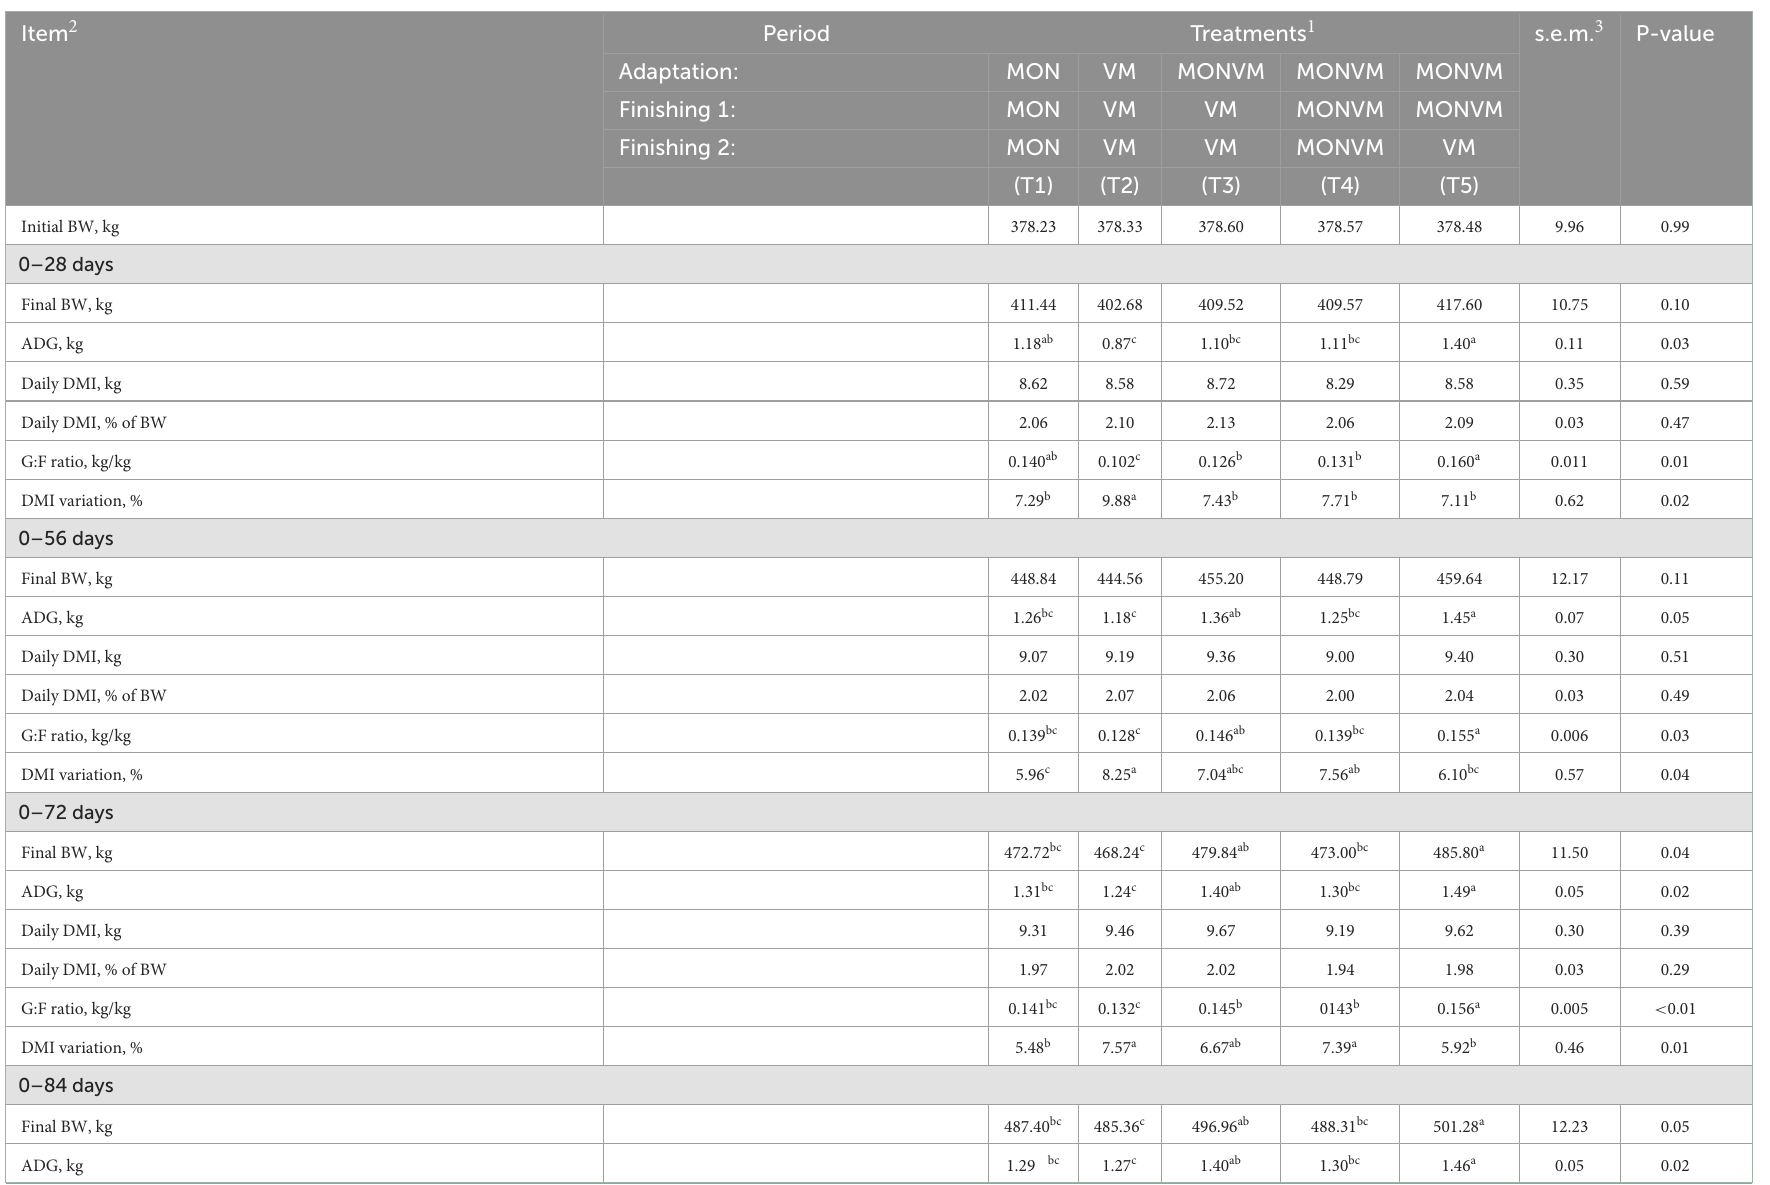
TABLE 2 Withdrawal of sodium monensin when associated with virginiamycin during adaptation and finishing periods on feedlot performance of Nellore yearling bulls ( n = 30) consuming high-concentrate diets. Item